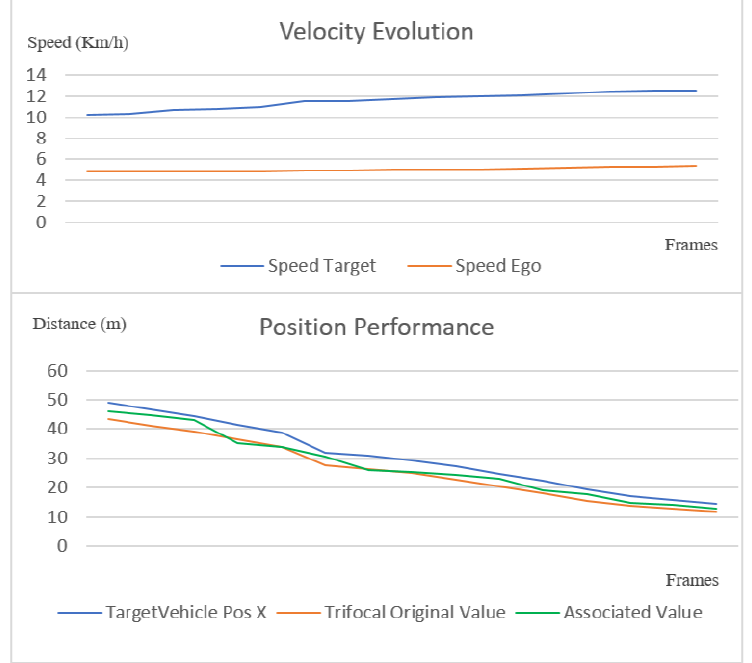
Figure 20. Speed chart (top) and position chart (bottom) of a trifocal object association